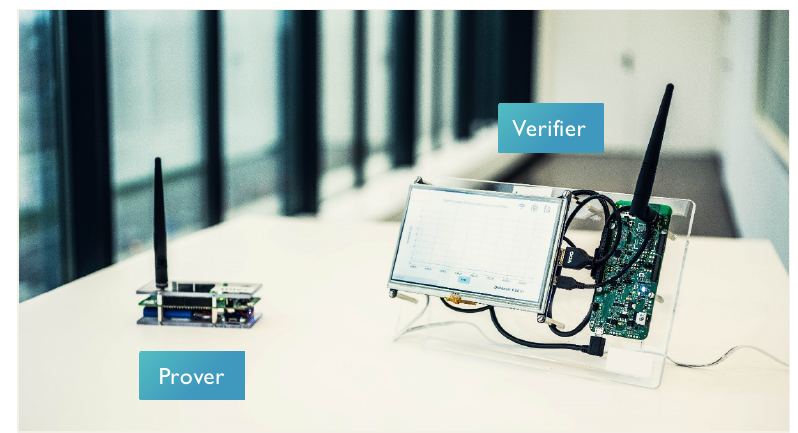
Figure 12: The proposed SDB solution is implemented on NXP KW36 chips.